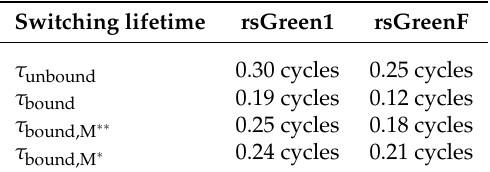
Table A1. Effect of molecular brightness on switching for the